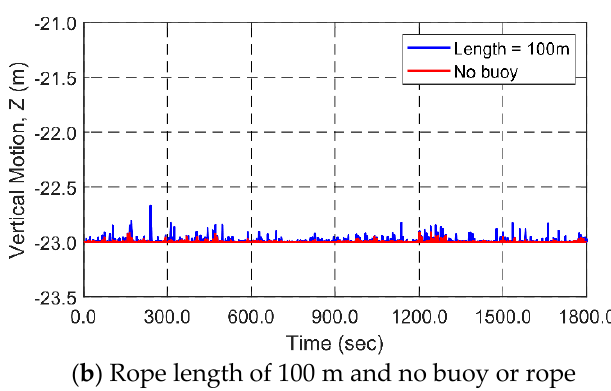
Figure 12. Time histories of the vertical motion of the net assembly at Y = 0 m, Z = − 23 min the middle location for H s = 2.0 m, T p = 7.0 s, and current velocity = 0.6 m/s (the bottom-set gillnet without location buoys was also simulated for comparison).